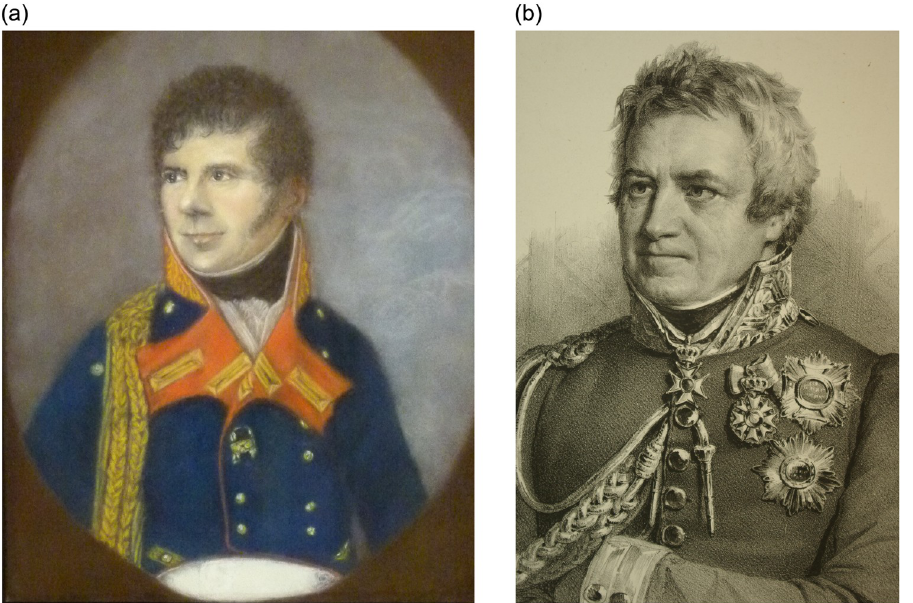
Fig 1. A: Count Heinrich LII Reuss-Ko¨stritz as Royal Bavarian General Major and Adjutant of the Bavarian King, around 1806; oil portrait by Leberecht Vogel von Vogelstein [Museum und Kunstsammlung Schloss Hinterglauchau, Germany; with permission]. B. Count Heinrich LII Reuss-Ko¨stritz around 1833 at the age of 70 years. Lithography by Hanfstaegel [Prof. Dr. A. Nerlich, Mu¨nchen, with